Question: State the chart type depicted above.
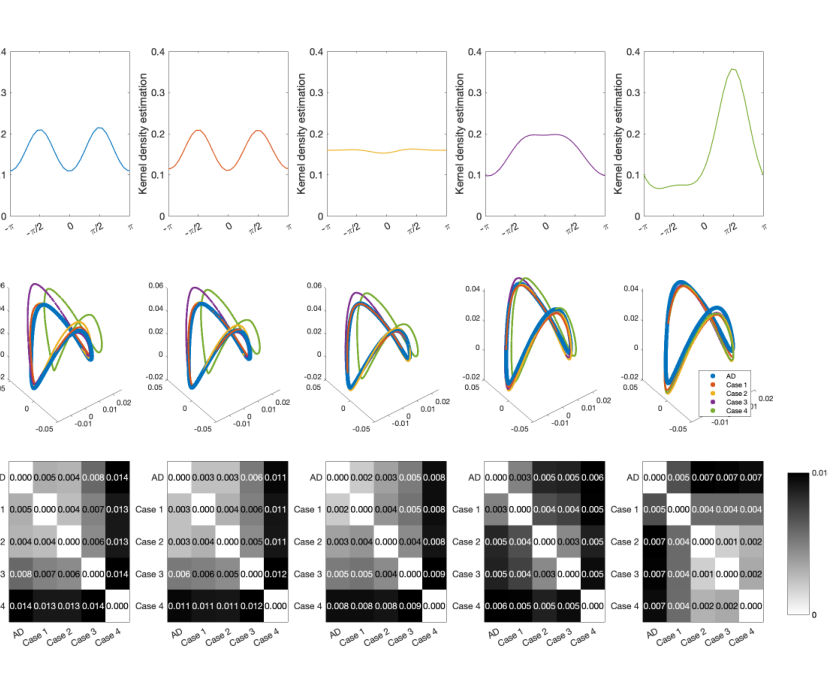
Answer: line